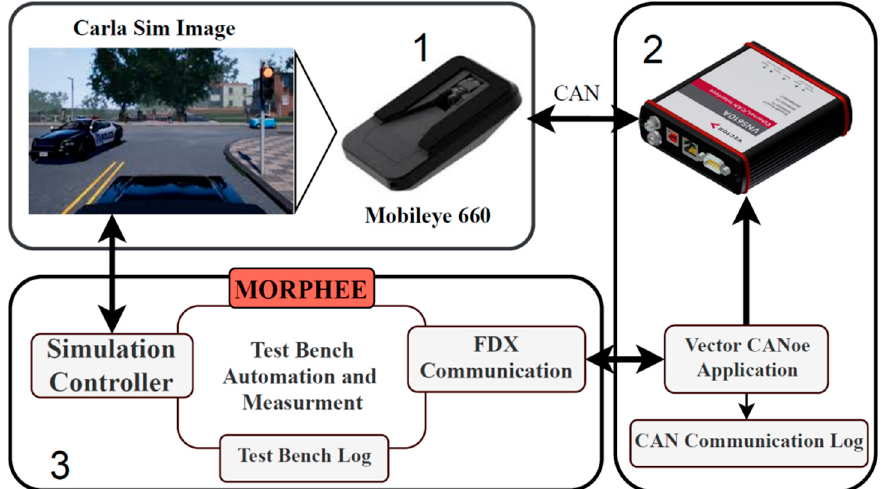
Figure 1. Diagram showing the three most important elements of the proposed HiL system. 1—Hardware part of framework, sensor and screen, 2—Can communication block VN5110A plus harness and Canoe, 3—Morphee automation software block.